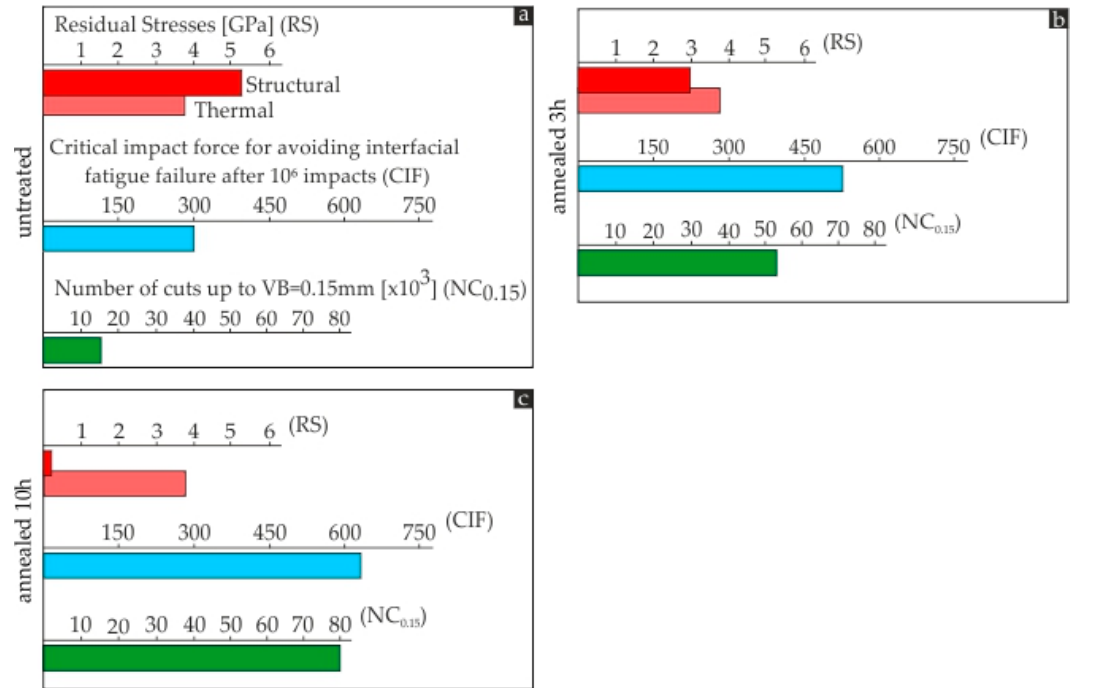
Figure 13. Correlation among NCD film residual stresses, interfacial fatigue strength as well as coated tool life in milling in the case of ( a ) an untreated coated tool; ( b ) an annealed one for 3 h at 400 °C; and ( c ) an annealed one for 10 h at 400 °C.